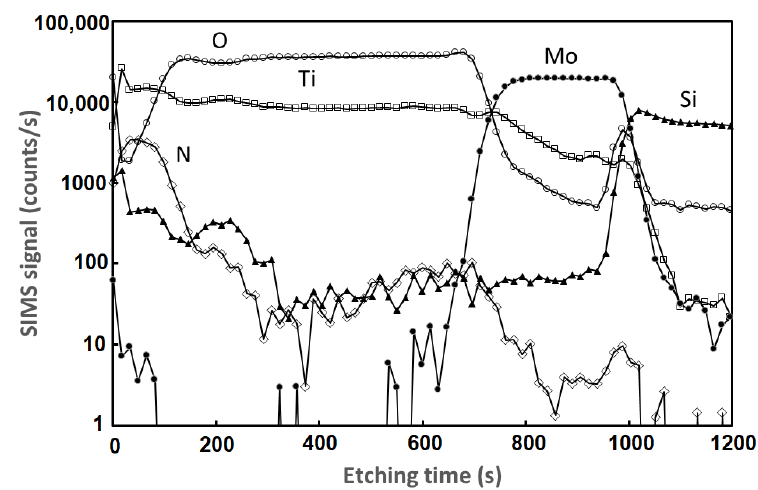
Figure 7. SIMS depth profiles of Mo–Ti bilayer film heated at 600 °C and exposed to (Ar-31%N 2 -6%H 2 ) plasma for 1 h.